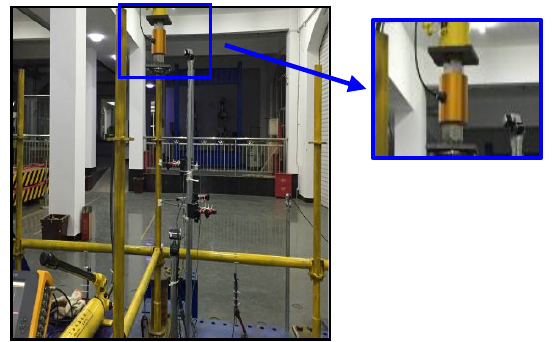
Figure 23. Experimental loading device.